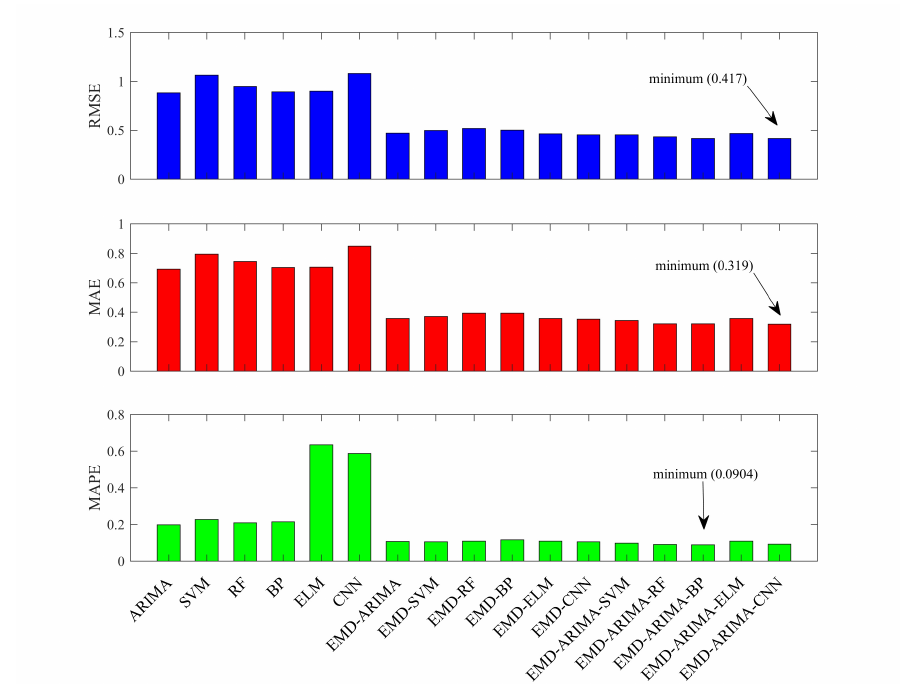
Figure 10. Wind speed prediction comparisons for the 1 h data at the AH site.